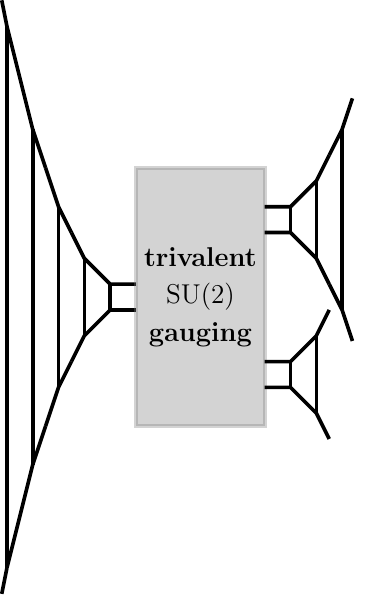
Figure 13 . A web-like of the 5d theory which is dual to the pure E 8 gauge theory.